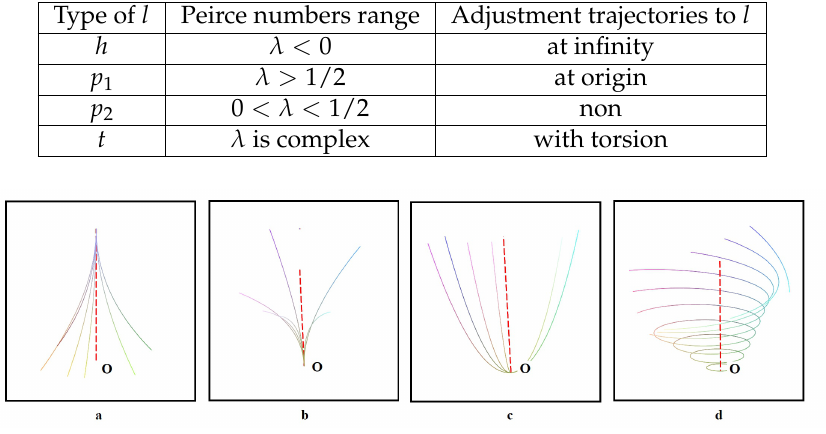
Figure 2. Types of the ray solution l : ( a )—type h , ( b )—type p 1 , ( c )—type p 2 , ( d )—type t ( in 3D